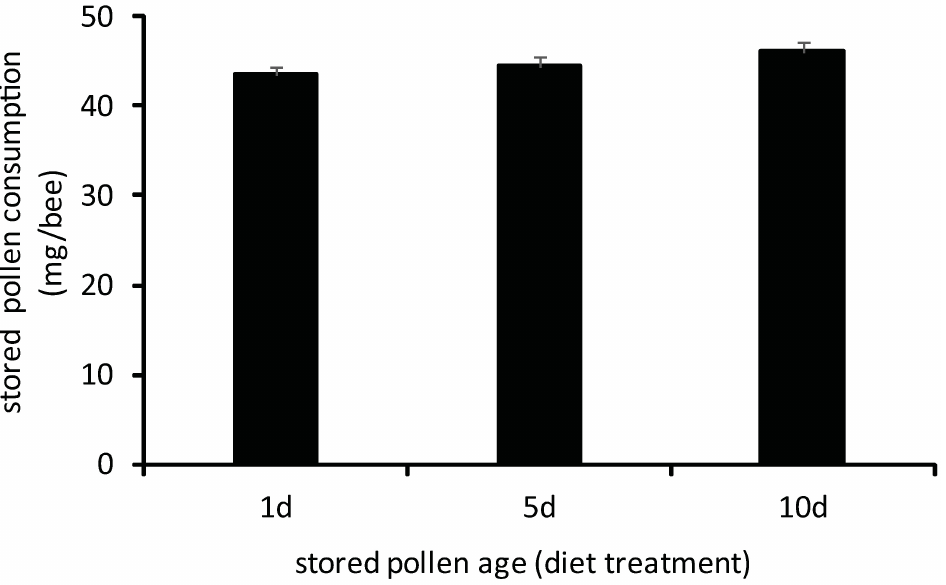
Fig 6. Average stored pollen consumption (fresh mass) of adult workers rearedexclusively for 7d on 1d-old, 5d-old, or 10d-old stored pollen. Treatment means did not vary significantly by a one-wayANOVA. (p < 0.05;error bars are